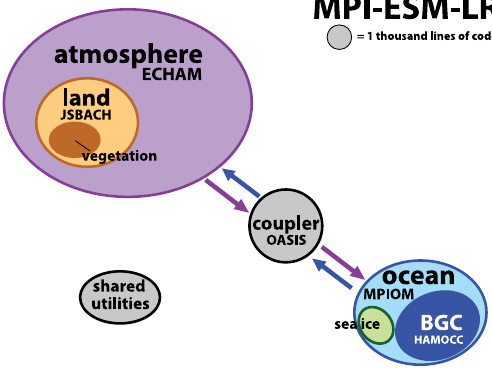
Figure 5. Architecture diagram for HadGEM2-ES.